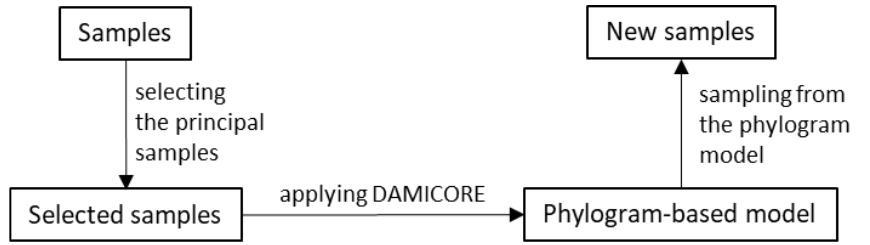
Figure 2. Diagram of the Optimization based on Phylogram Analysis — OPA.